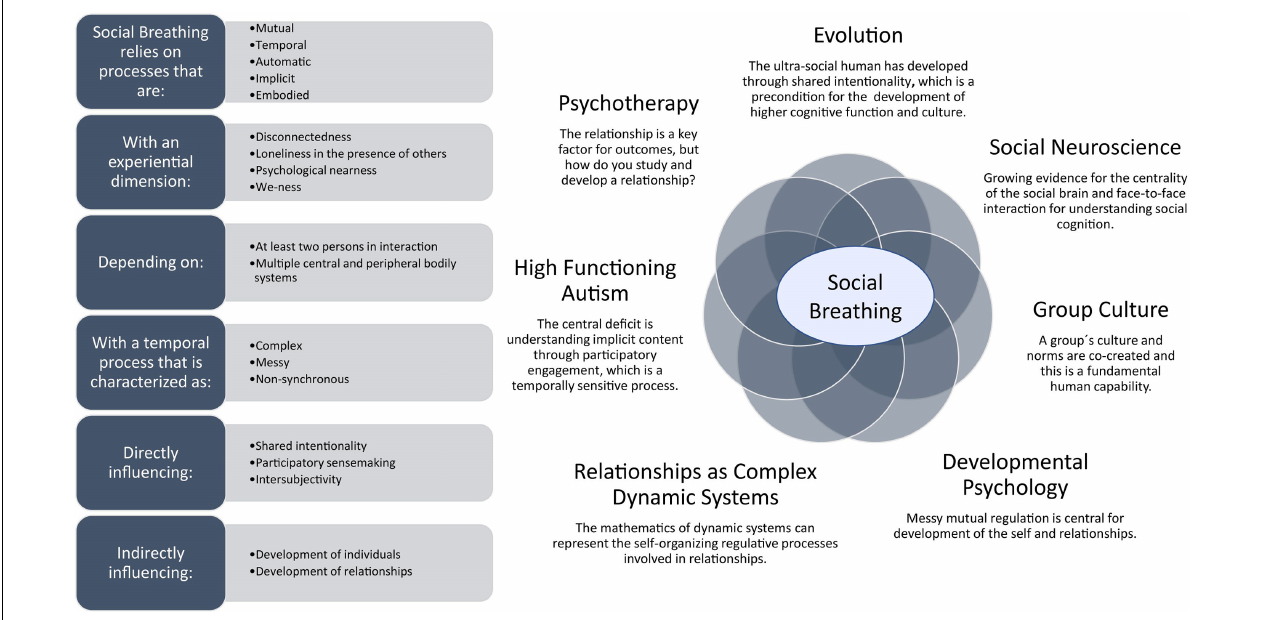
FIGURE 1 | Social Breathing is a latent construct (e.g., a theoretical entity that cannot be measured directly) representing the fundamental human activity of becoming engaged in a social interaction, including sharing intentions, joint meaning-making, and complex coordination. We list its characteristics in the panel on the left. Numerous research areas attempt to capture this elusive “something” but none address all aspects of Social Breathing. On the right we show a representative, but not exhaustive, set of such research domains. We use Social Breathing to synthesize across domains, making it easier to develop specific and testable